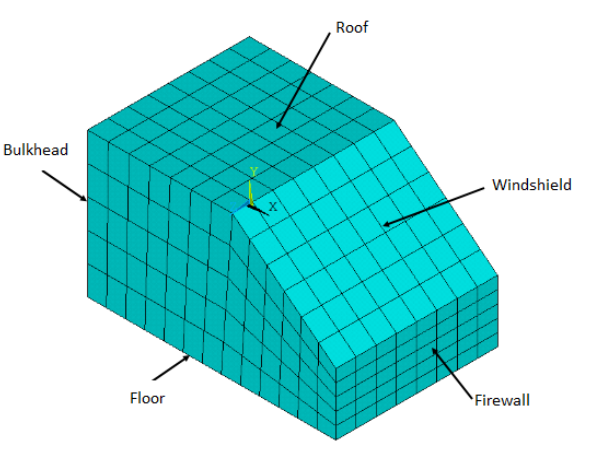
Figure 11. 3D model of the passenger cavity.